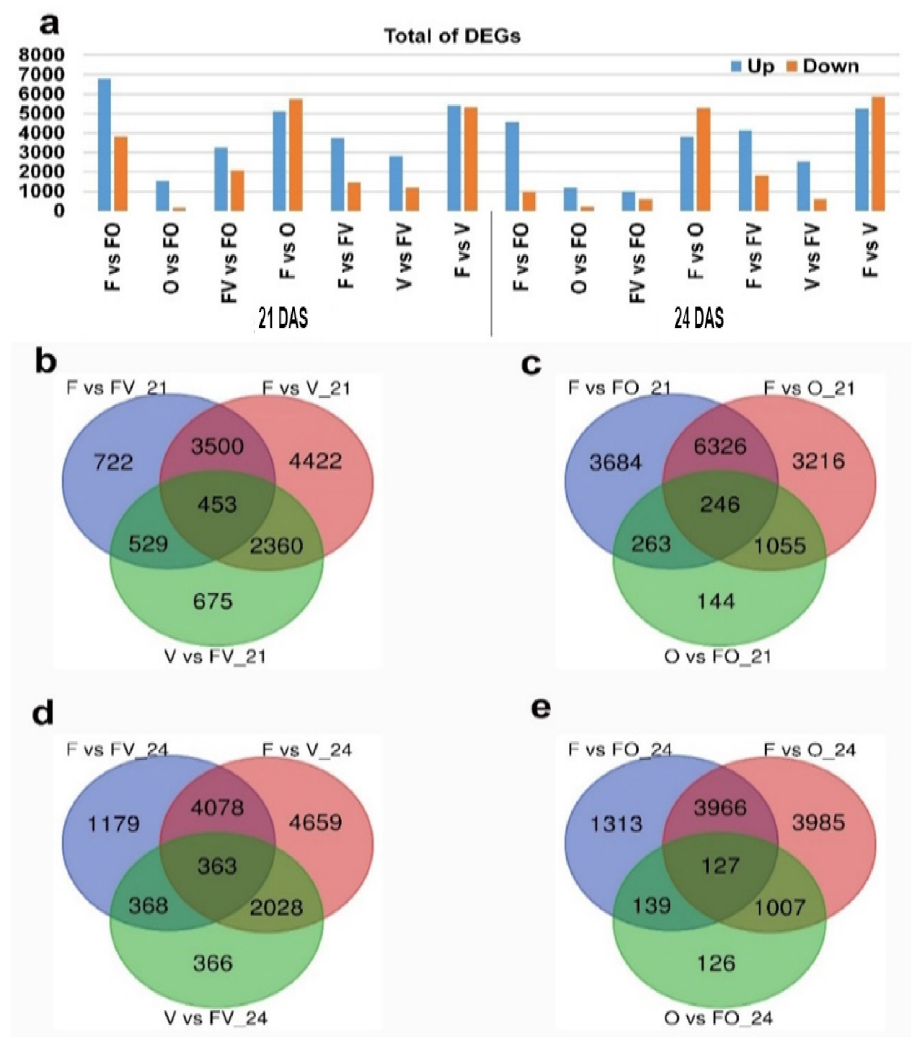
Figure 2. The distribution of differentially expressed genes (DEGs) in root samples of two contrasting hybrids and their parents at 21 and 24 days after sowing (DAS). ( a ) A column chart observes the total number of DEGs (up and down-regulation). ( b , d ) Venn diagrams represent distributions of uniquely and commonly DEGs in low hybrid parent triad (FV). ( c , e ) Venn diagrams show the distribution of unique and common DEGs in a high hybrid parent triad (FO). O and V: represent maternal parents. F: represents the paternal